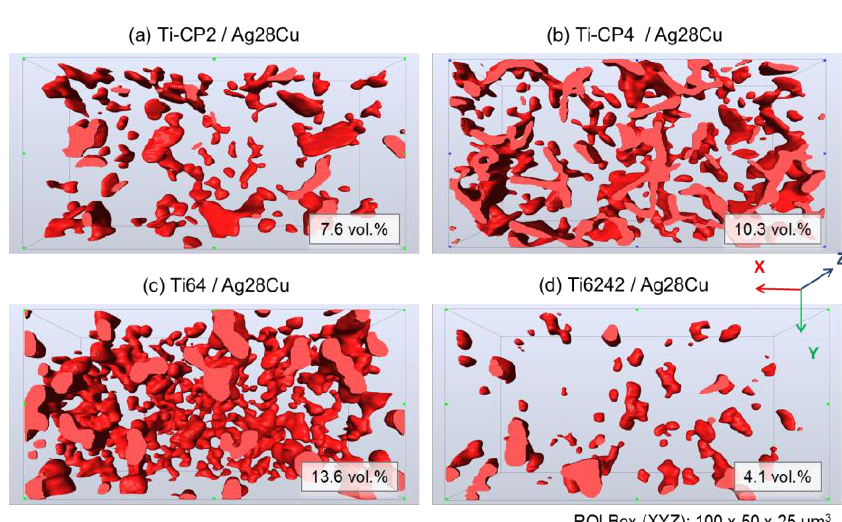
Figure 4. Comparative 3D visualizations of the intermetallic particles embedded in the Ag-rich region (horizontal cuts of the isometric top view): ( a ) Ti-CP2/Ag28Cu, ( b ) Ti-CP4/Ag28Cu, ( c ) Ti64/Ag28Cu, ( d ) Ti6242/Ag28Cu.The Ag-rich region is transparent. The total volume fractions specified here were determined from volumes of 300 × 300 × 50 µm³.